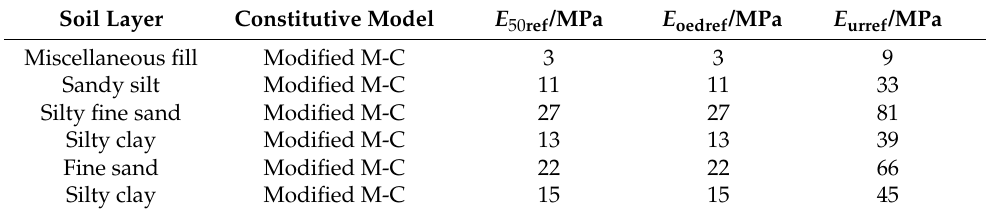
Table 4. Geotechnical mechanics parameter